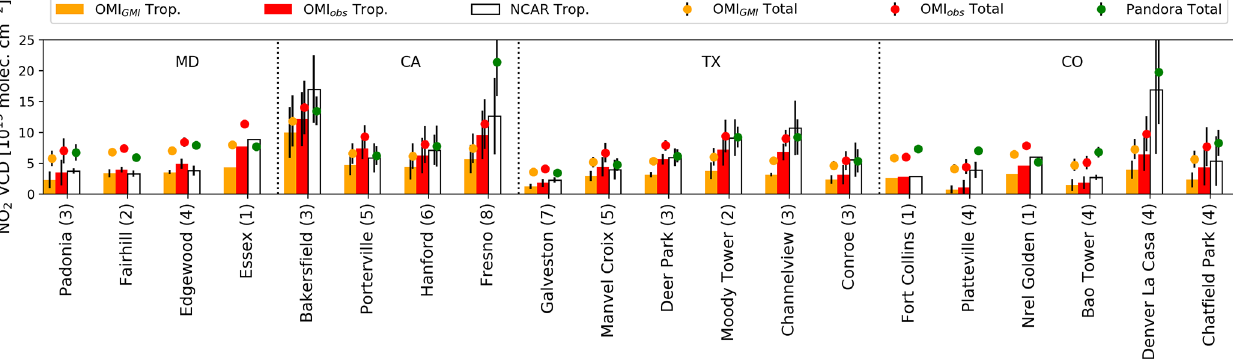
Figure 15. Site average total (circles) and tropospheric (bars) NO 2 column data from the P-3B spiral (white bars), Pandora (green circles), and OMI (orange and red). The OMI tropospheric columns are derived using GMI-simulated (OMI GMI , orange) and P-3B (OMI obs , red) NO 2 profiles. The vertical bars for sites with over two observations represent the standard deviations. Table 2. Comparison of OMI V3.1 and V4.0 NO 2 retrievals based on a priori NO 2 profiles from GMI (OMI) and P-3B aircraft observa- tions (OMI obs ) to P-3B observations during the DISCOVER-AQ field campaign. Shown here are the correlation coefficient ( r ) and mean difference, which is calculated as OMI minus validation data. Campaign V3.1 V4.0 locations OMI vs. P-3B OMI obs vs. P-3B OMI vs.